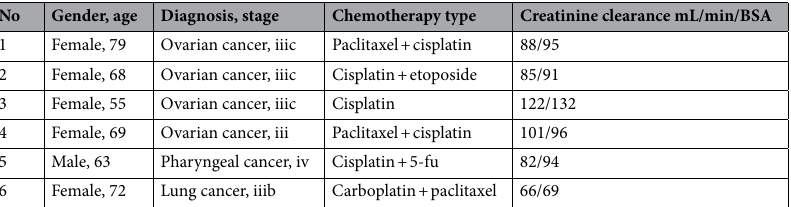
Table 2. Patient characteristics with the level of creatinine in the blood before/after chemotherapy. BSA body surface area.